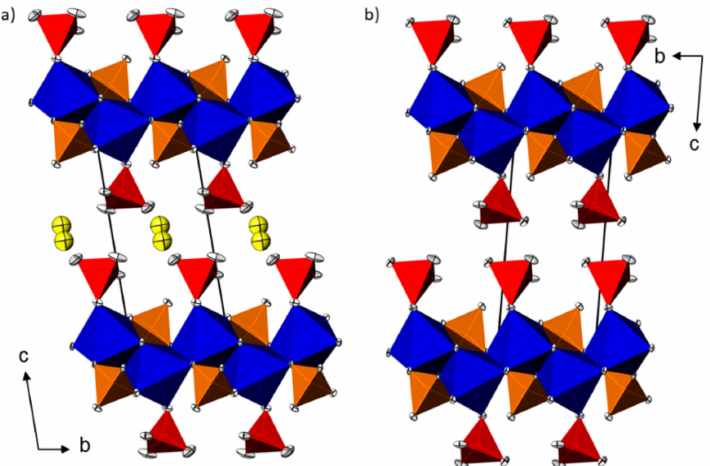
Figure 2. ( a ) Representative for the two M (HAsO 4 )(H 3 AsO 4 )(H 2 O) 0.5 ( M = Mn, Cd) compounds, the crystal structure of Mn(H 2 As O 4 ) 2 (H 3 AsO 4 ) 2 is given in a projection along (100); ( b ) the crystal structure of Zn(HAsO 4 )(H 3 AsO 4 ) in a projection along (100). Displacement ellipsoids are drawn at the 50% probability level. HAsO 42 − tetrahedra (As1) are orange, H 3 AsO 4 tetrahedra (As2) are red, and M O 6 octahedra are blue. Water molecules are yellow, with both possible positions (occupancy 0.5)